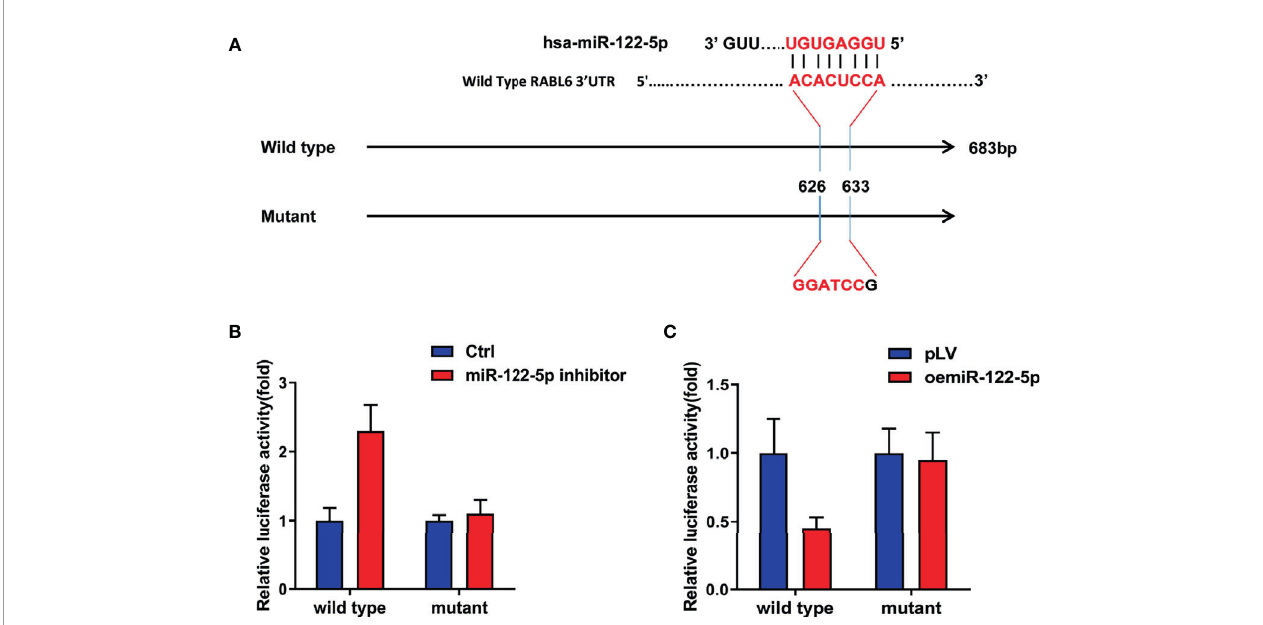
FIGURE 4 | MiR-122-5p directly targets 3 ’ UTR of RABL6 mRNA to regulate RABL6 expression. (A) Pattern diagram of the design of mutant type 3 ’ UTR of RABL6. (B) Luciferase activities were measured when adding miR-122-5p inhibitor in Hep3B wild type and mutant cells compared to the control cells. (C) Luciferase activitIes were measured when overexpressing miR-122-5p in PLC/PRF/5 RABL6 wild type and mutant cells compared to the control